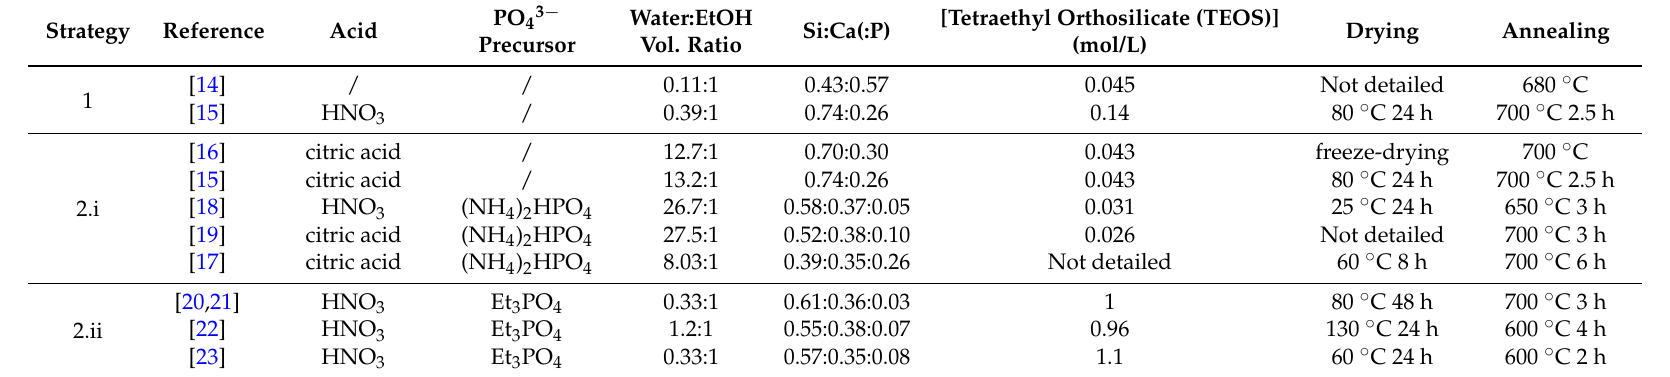
Table 1. Comparison of experimental conditions for different sol-gel syntheses